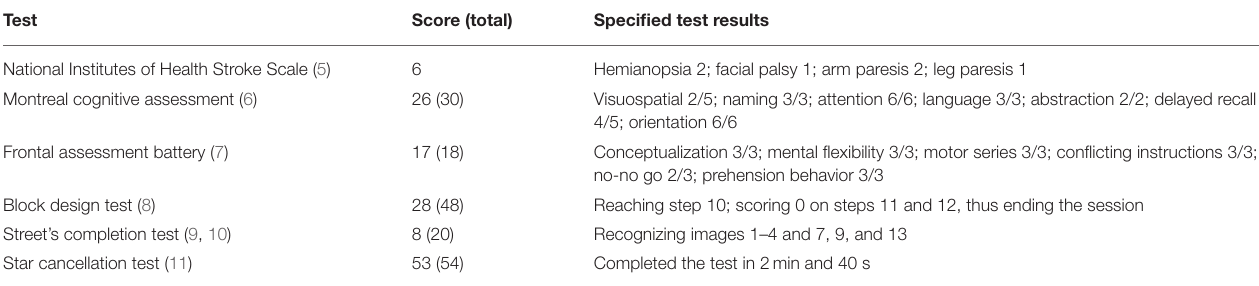
TABLE 1 | Clinical, cognitive, and visuospatial evaluation of the patient, 6 years after a right-sided malignant middle cerebral artery infarct resulting in near-complete right hemispherectomy. Test Score (total) Specified test